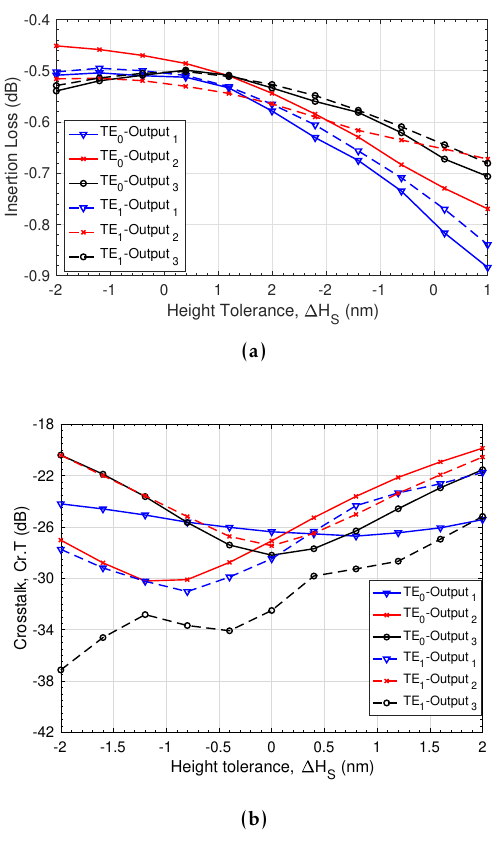
. 2 Figure 11. Insertion loss (a) and crosstalk (b) of the proposed switch as a function of the slab-height